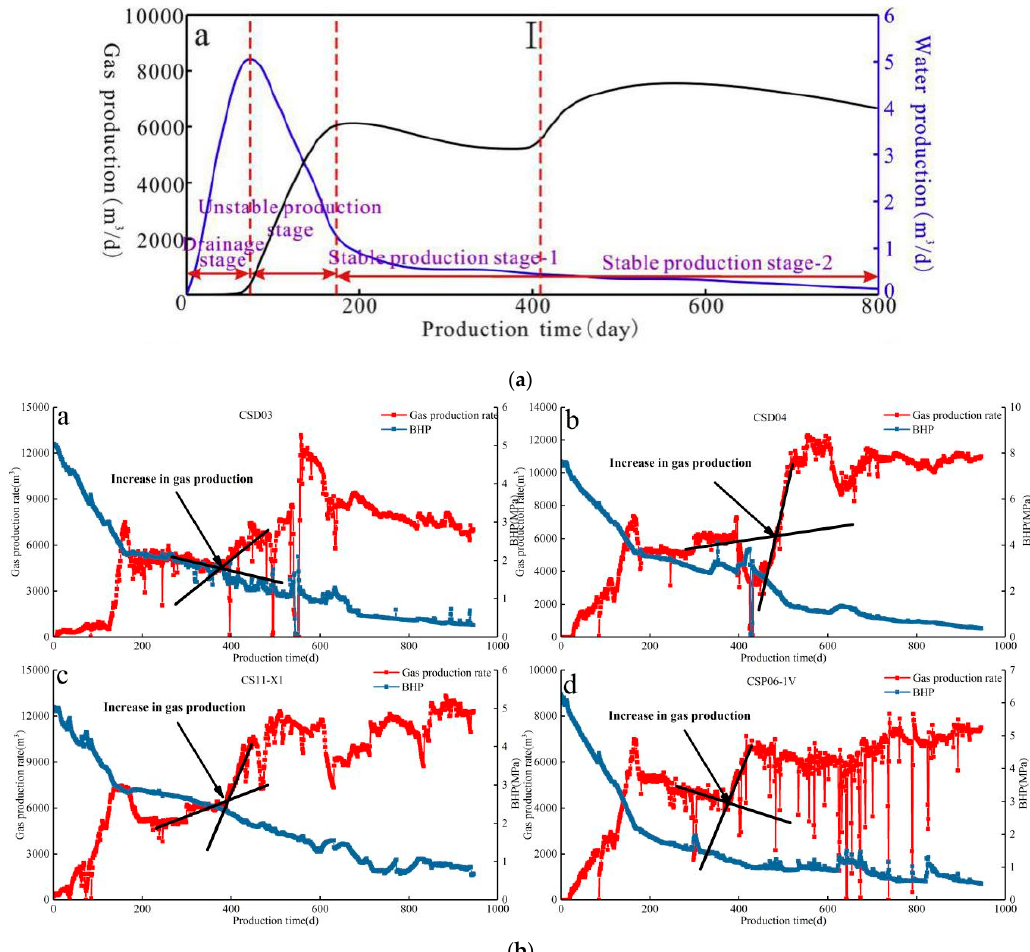
Figure 6. Production rate curves from previous research projects, ( a ) water and gas production profiles of steeply-dipping reservoirs in the west Fukang Block [16], ( b ) gas production profiles for four CBM wells of well site 11 of the Fukang western block [39].